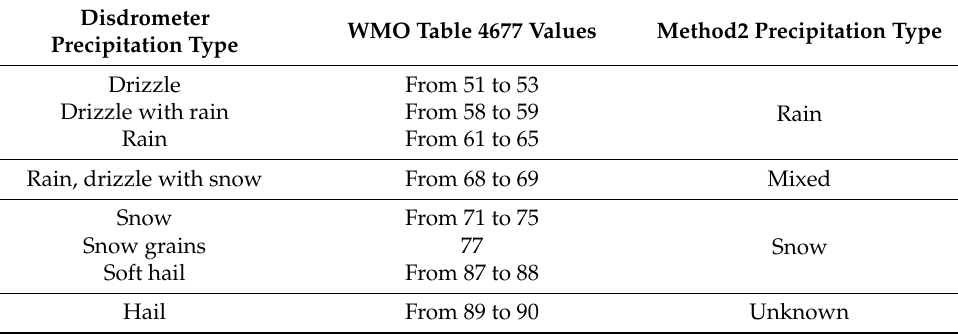
Table 4. Correspondence between precipitation types observed by the disdrometer (WMO Table Table 4. 4677) and precipitation types estimated with Method2. Table 4677) and precipitation types estimated with